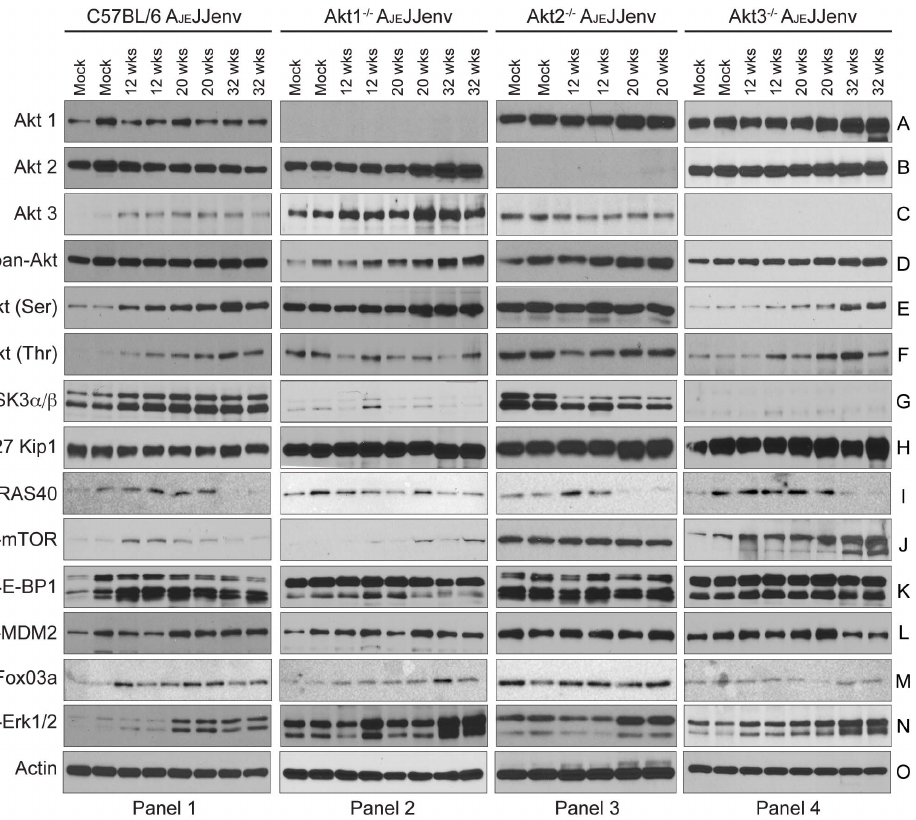
Figure 6. Akt isoform expression and Akt pathway activation in lungs from WT, Akt1 2 / 2 , Akt2 2 / 2 and Akt3 2 / 2 mice infected with A JE JJenv. Representative western blot images of 80 ug of total protein extracts from the lungs of A JE JJenv infected WT (panel 1), Akt1 2 / 2 (panel 2), Akt2 2 / 2 (panel 3), and Akt3 2 / 2 (panel 4) mice at 12, 20 and 32 weeks post-infection probed with Akt isoform specific antibodies (A to C), pan-Akt (D), a panel of phospho-specific (p) antibodies (E to N) and actin (O) as a loading control.